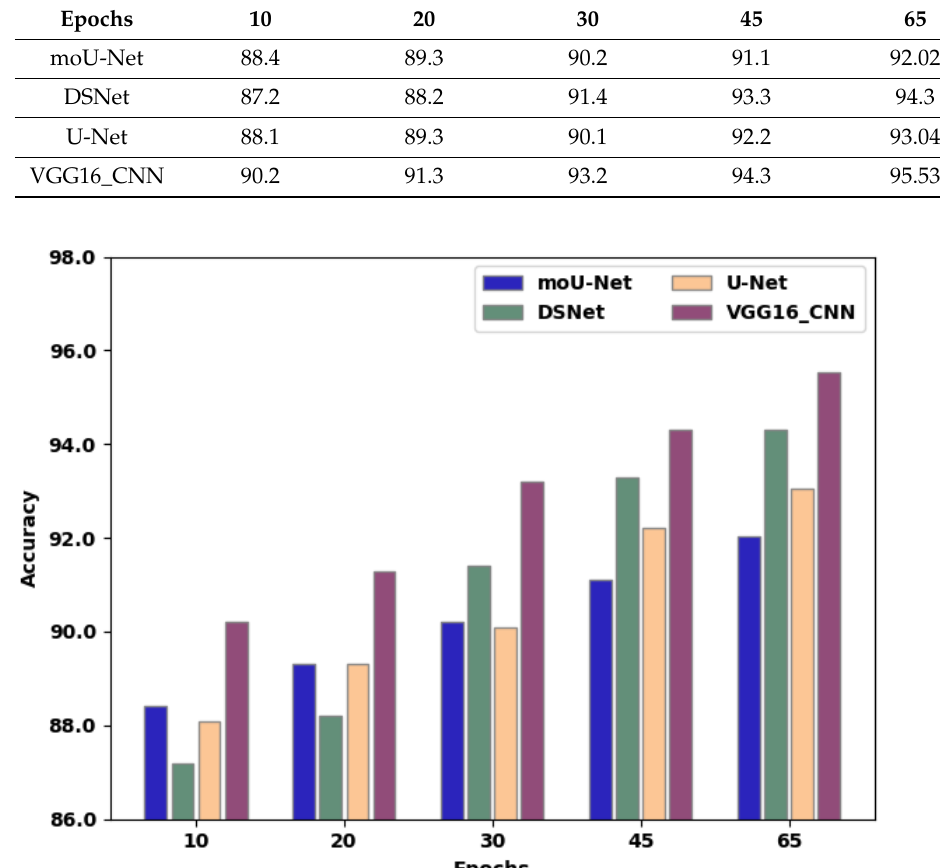
Figure 8. Accuracy comparison of existing techniques and the proposed method.